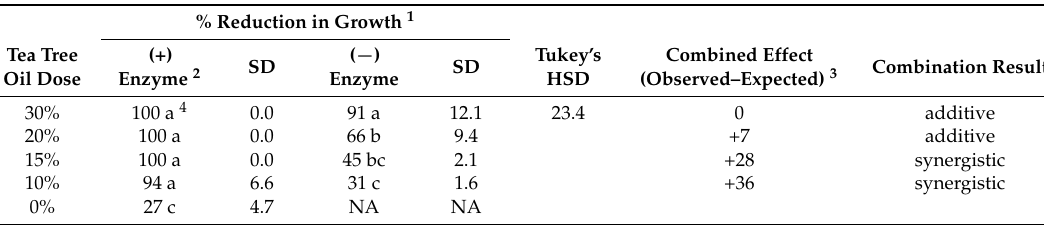
Table 6. Inhibition of Pythium ultimum by the stabilized LPO formulation alone and in combination with tea tree oil using fungicide-impregnated filter paper disks.